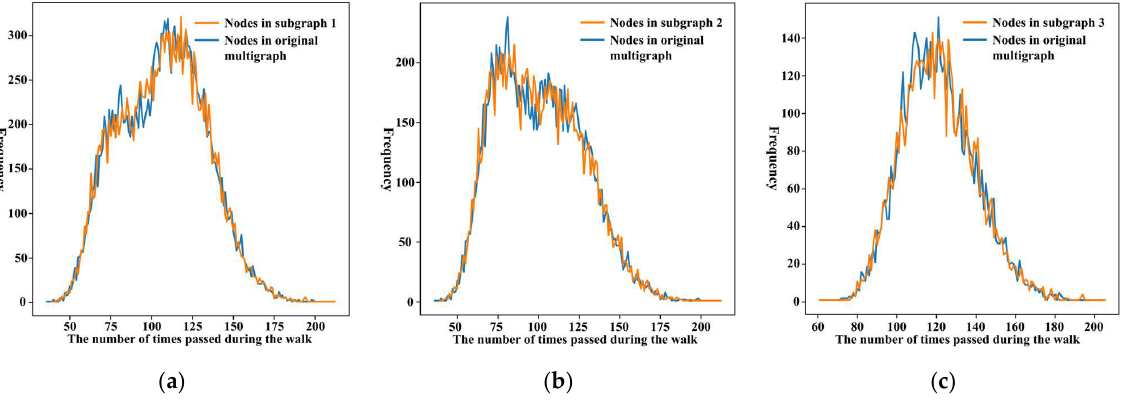
Figure 7. Frequency distribution of each node in three subgraphs: ( a – c ) via the sequences generated based on the original multigraph (blue line) and partitioned subgraphs (orange line).